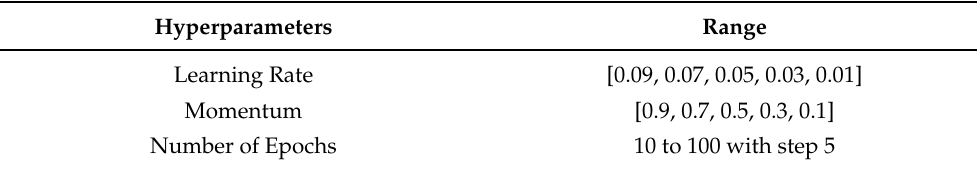
Table 2. Utilized hyperparameters range to obtain optimal CNN.